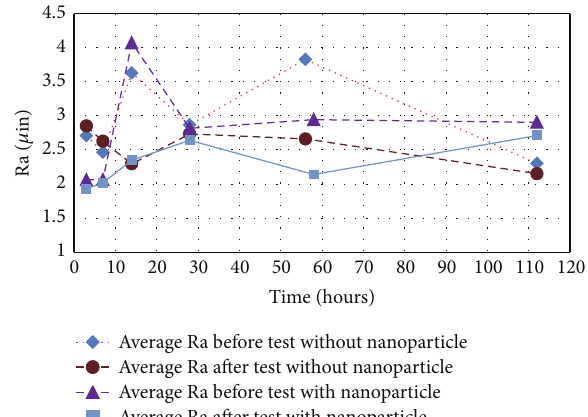
Figure 6: Average Ra roughness for alloy 110 copper before and after 3-, 7-, 14-, 28-, 56-, and 112-hour treatments with the reference fluid of 50/50% ethylene glycol in water and with nanofluid of 2% nanoalumina in reference